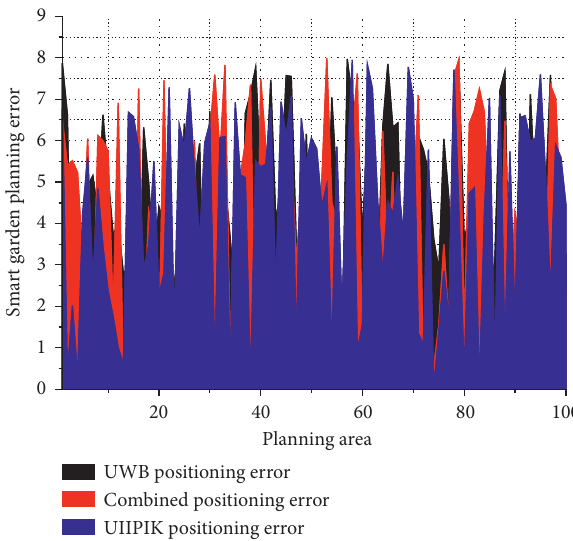
Figure 3: Analysis of different types of experiential activities’ settings.